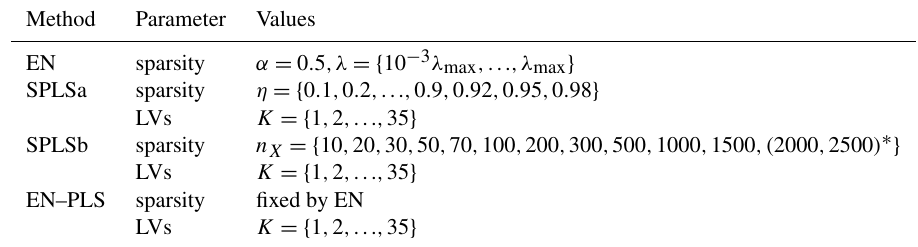
Table B1. Summary of sparse methods and